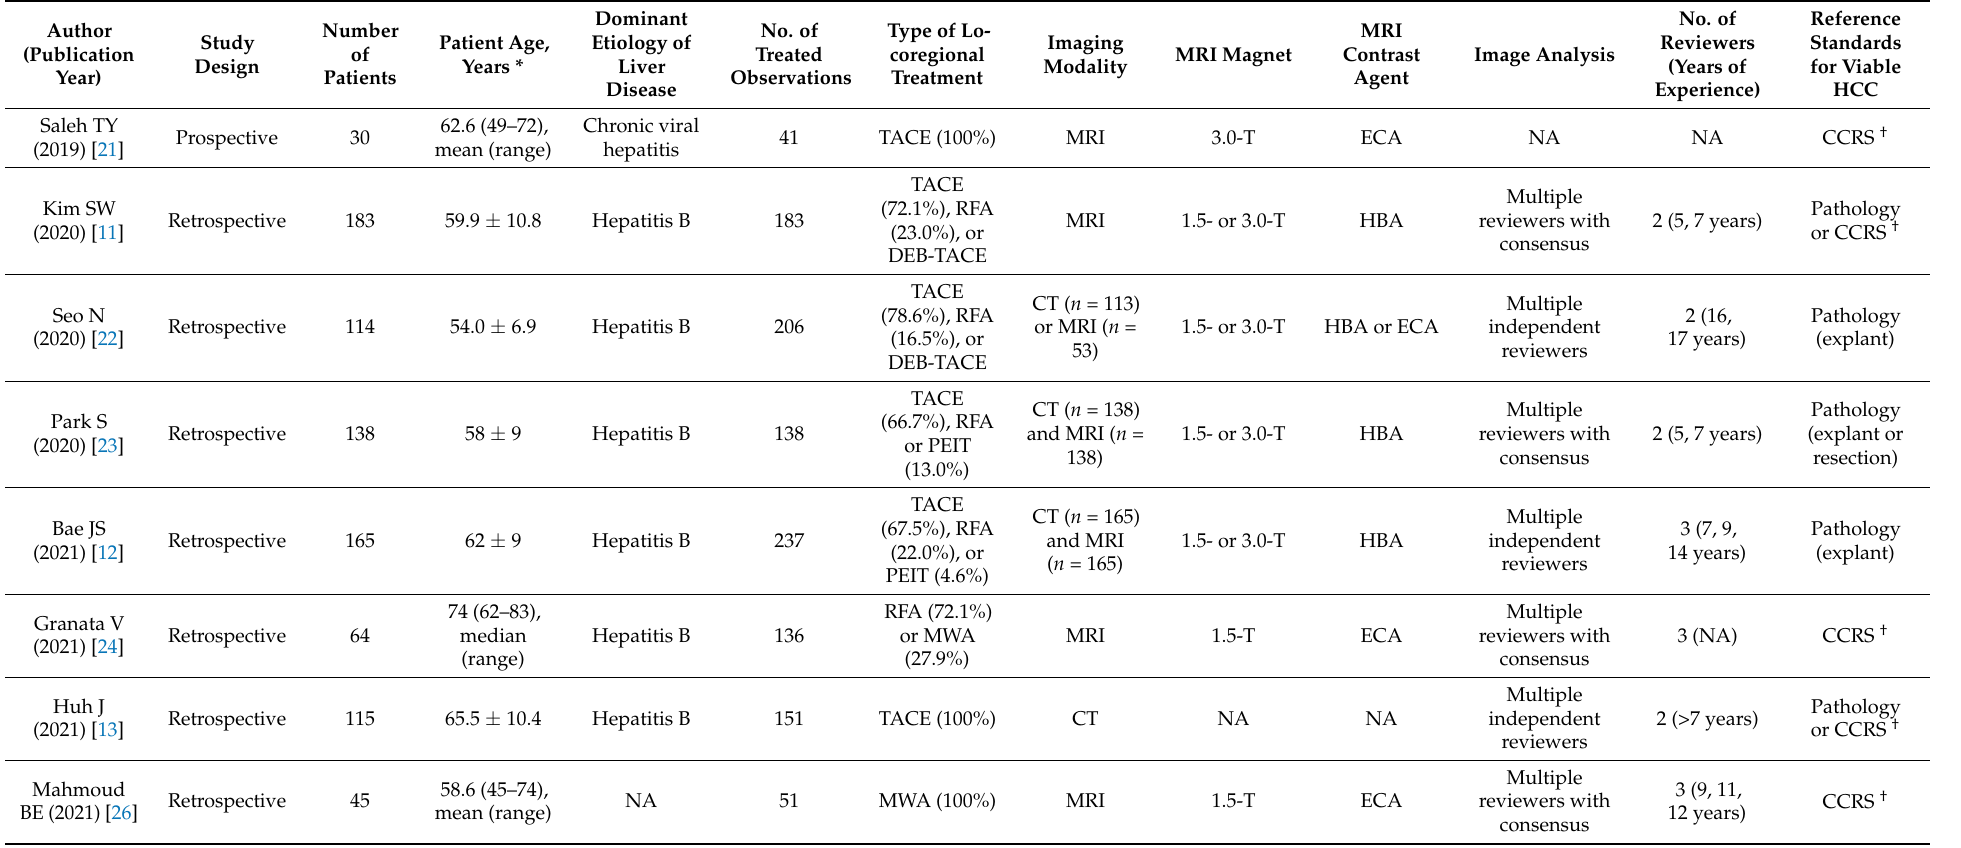
Table 1. Characteristics of included